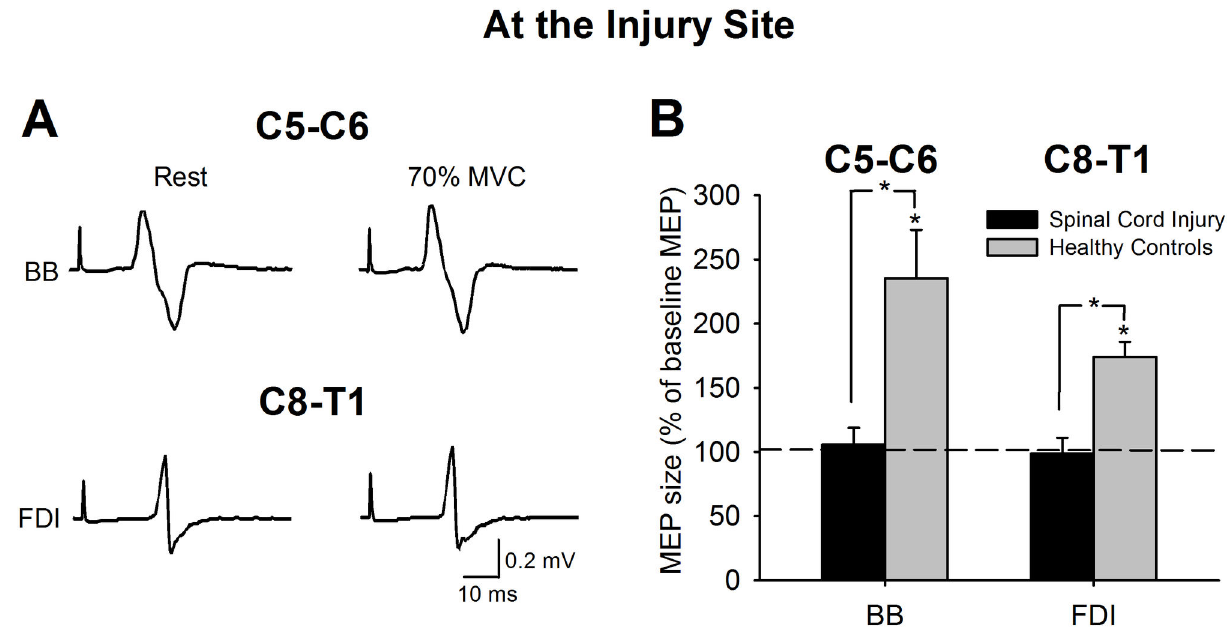
Figure 2. MEPs at the injury site. (A) MEPs recorded from the resting BB and FDI of representative patients with a C5-C6 and C8-T1 SCI, while the other side remained at rest or performed 70% of elbow flexion or index finger abduction. Group data (B, healthy controls, n=17; C5-C6, n=9, C8-T1, n=5). The abscissa shows the muscle tested (BB and FDI). The ordinate shows the size of BB and FDI MEPs as a % of the baseline BB and FDI MEPs. Note the increase in BB and FDI MEP size during contralateral index finger abduction and elbow flexion in healthy controls, but not in patients with C5-C6 and C8-T1 SCI. Error bars indicate SEs. *p < 0.05. doi: